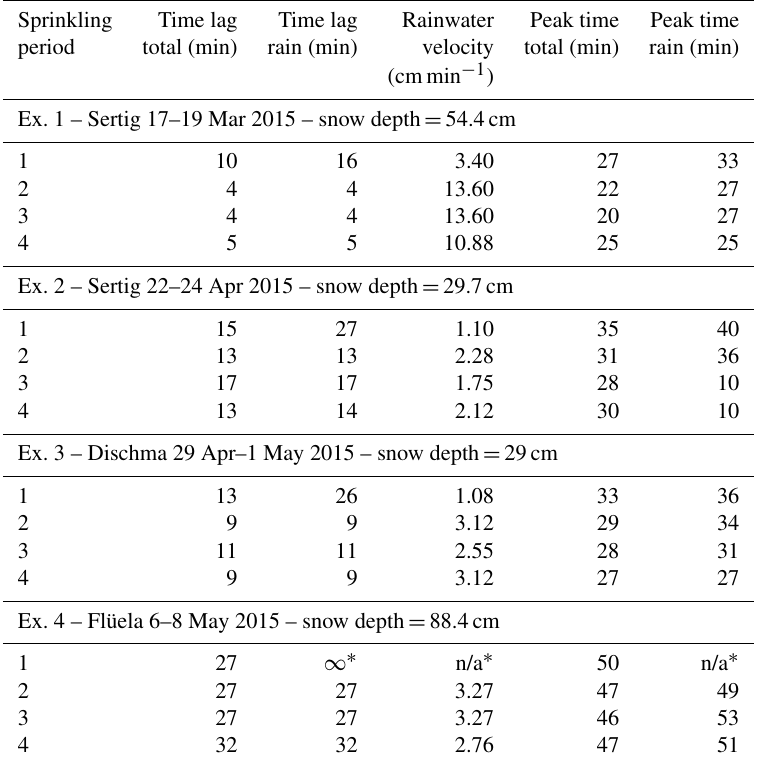
Table 4. Hydrograph analysis of different artificial ROS events.